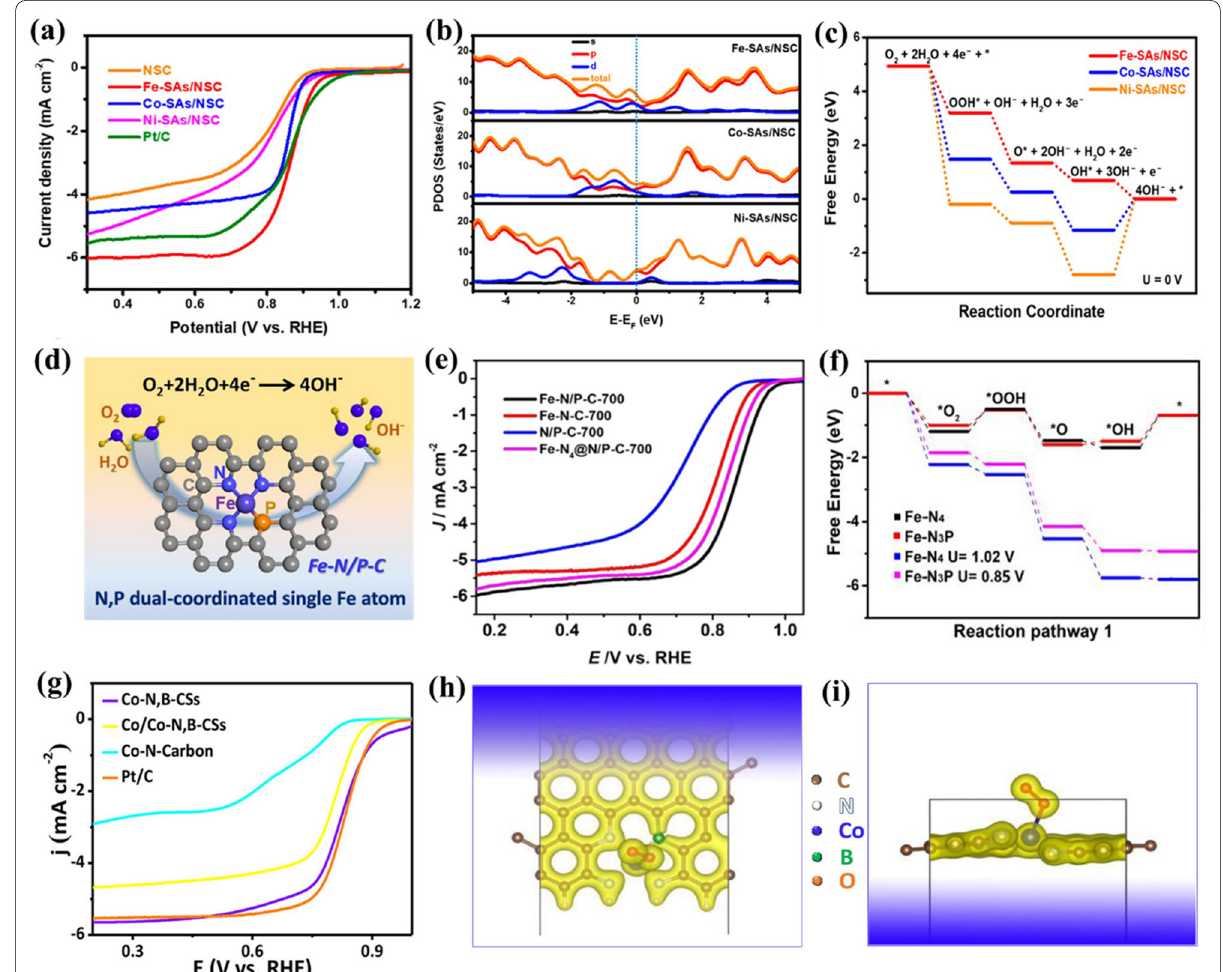
Fig. 7 a LSV curves of Fe‑SAs/NSC (Fe‑N 4 S 2 ), Co‑SAs/NSC (Co‑N 3 S 1 ), Ni‑SAs/NSC (Ni‑N 3 S 1 ) and reference samples in O 2 ‑saturated 0.1 M KOH solution. b The calculated partial density of states (PDOS) of Fe‑SAs/NSC (Fe‑N 4 S 2 ), Co‑SAs/NSC (Co‑N 3 S 1 ), and Ni‑SAs/NSC (Ni‑N 3 S 1 ). c Free energy diagrams of ORR on Fe‑SAs/NSC (Fe‑N 4 S 2 ), Co‑SAs/NSC (Co‑N 3 S 1 ), and Ni‑SAs/NSC (Ni‑N 3 S 1 ). d Structural model of Fe‑N 3 P 1 site for ORR. e LSV curves of Fe‑N/P‑C‑700